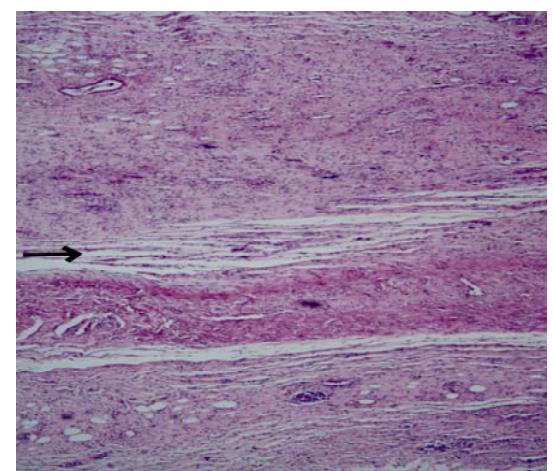
FIGURE 18 - Histological view shows perfect adherence of the parietal peritoneum